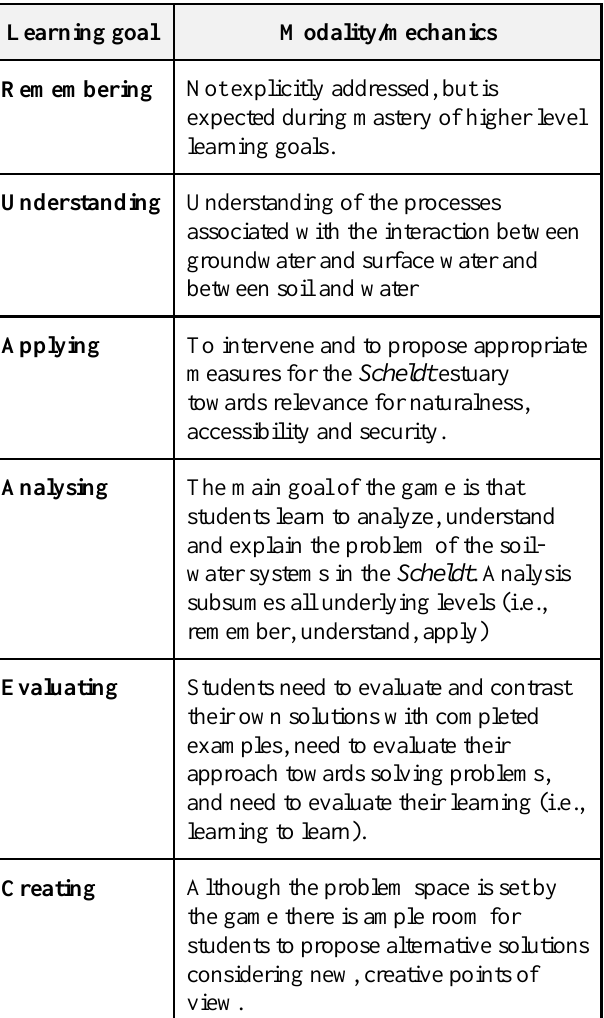
Table 2 : Bloom’s cognitive learning goals covered by the